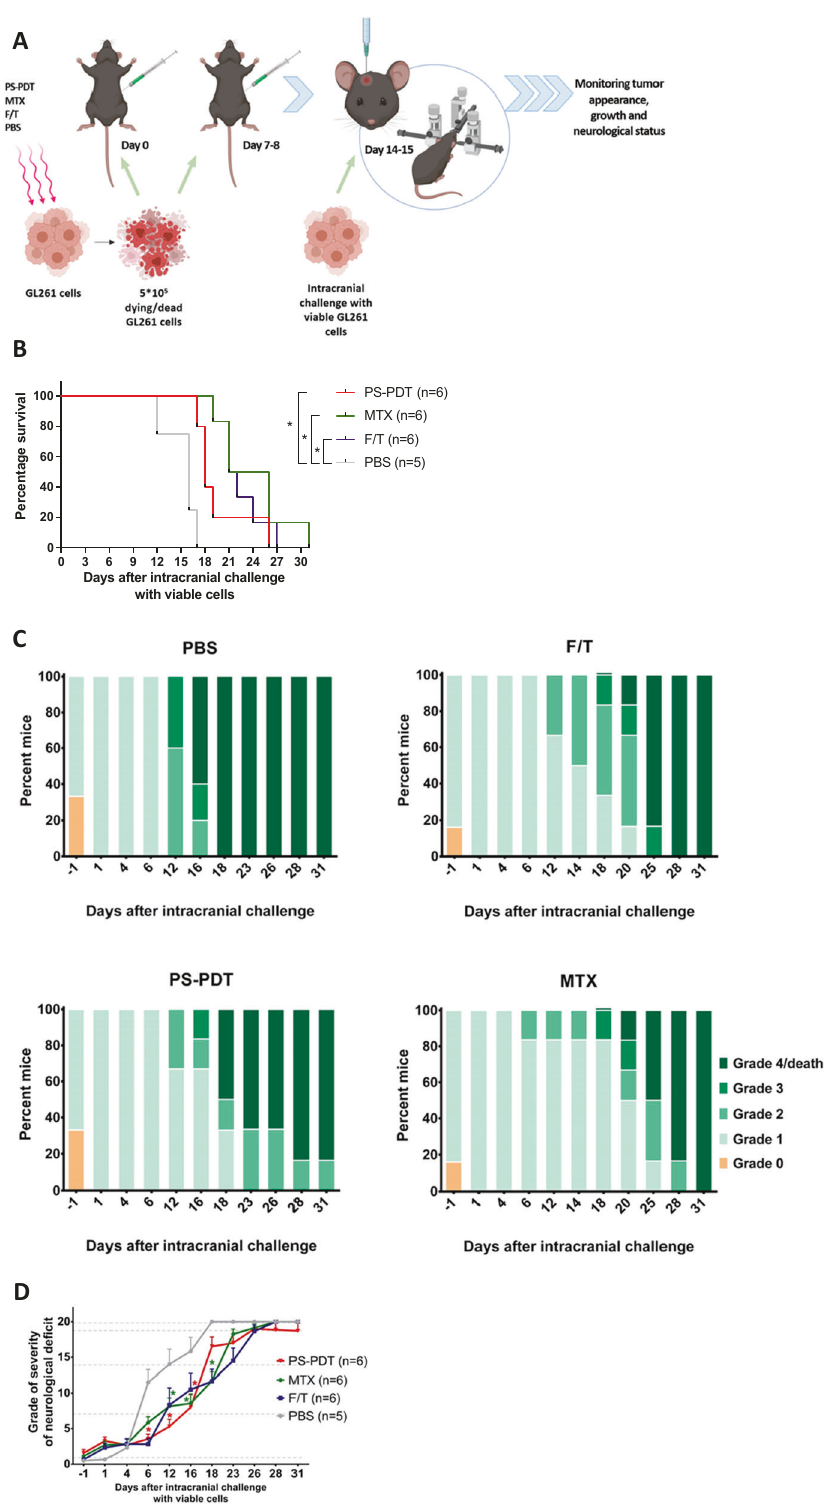
Fig. 2 Subcutaneous vaccination with glioma GL261 cells pulsed with PS-PDT protects in the orthotopic high-grade glioma (HGG) mouse model. A Experimental setup for the prophylactic vaccination of mice injected with GL261 cells treated with three F/T cycles or 2.0 µM MTX, or loaded with 1.4 µM photosens and exposed to PDT (PS-PDT), or injected with PBS. The mice were vaccinated on days 0 and 7 and challenged by intracranial stereotactic injection of viable GL261 cells on day 14. B Survival of mice vaccinated and challenged with GL261 cells as described in ( A ). * p < 0.01, Mantel-Cox logarithmic test. C , D The percentages of mice showing neurological alterations is shown (grade 0, grade 1, grade 2, grade 3, grade 4). The neurological status of the mice was assessed every 2 – 4 days for up to day 31 after intracranial tumor inoculation. N = 5 – 6 per group. * p < 0.05, a statistically signi fi cant difference from the PBS group; Wilcoxon